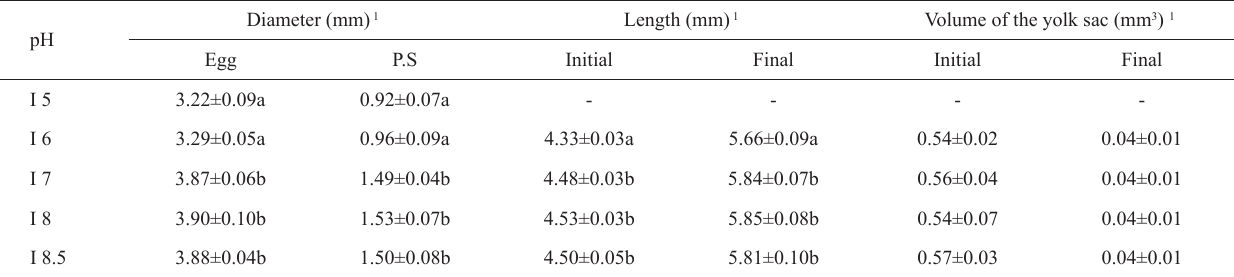
Table 2. Average values ± standard deviation of the Diameter of the egg, Perivitelline Space (P.S), Length of the larvae (initial and final), Volume of the Yolk Sac (initial and final) during the incubation of Prochilodus lineatus at the different pH values tested. 1 Different letters in the same column indicate statistical differences in the averages by the Tukey test (P < 0.05).